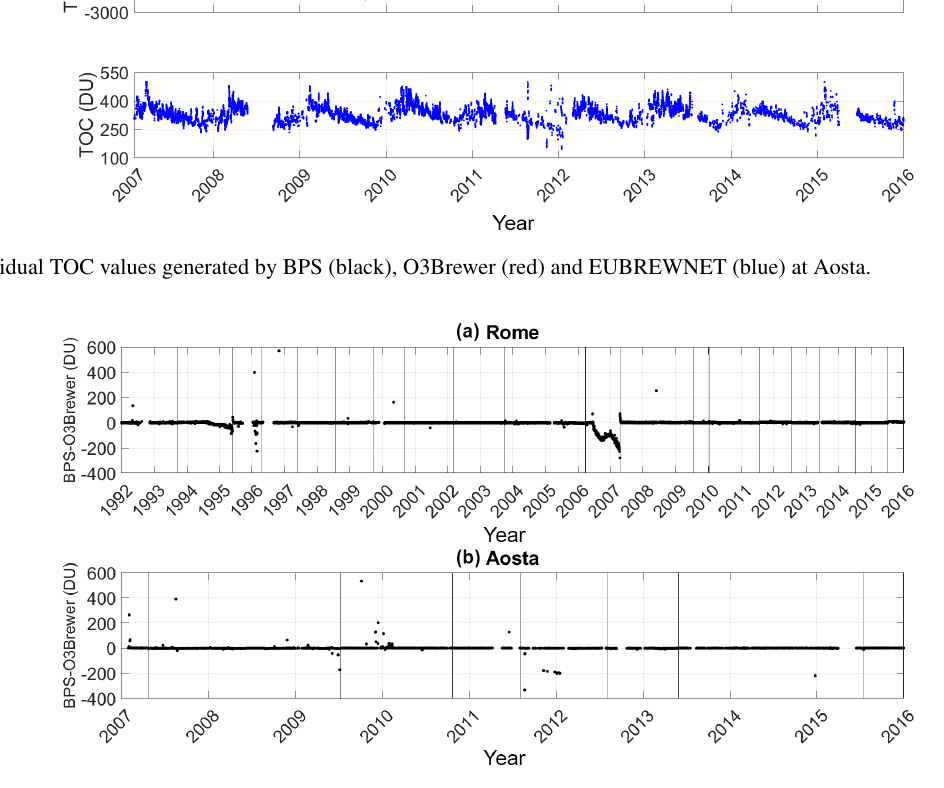
Figure 4. Time plot of the differences between BPS and O3Brewer daily means at Rome (a) and at Aosta (b) . Vertical lines represent the date of the calibration